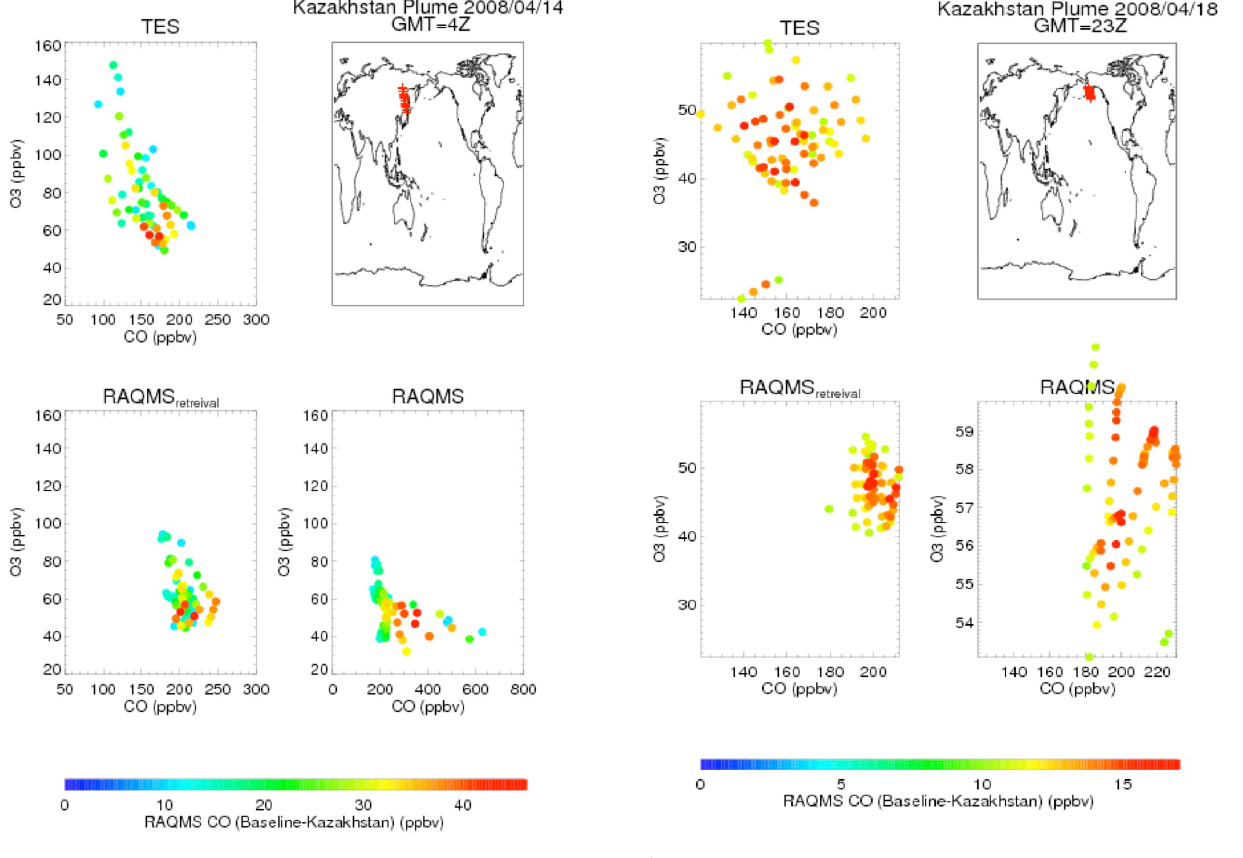
Fig. 8b. Same as in Fig. 8a but over Siberia. Figure 8b : Same as in 8a but over Siberia Table 1. Dates, locations and UTC time of each TES profile used during the Kazakhstan/Siberian wildfire plume study.